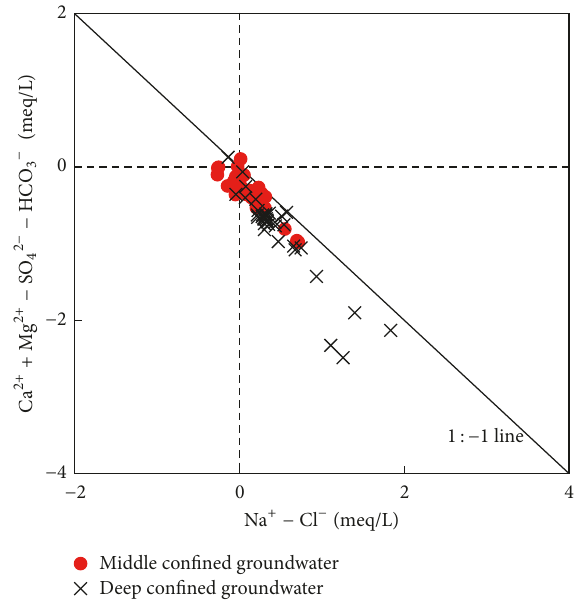
Figure 10: Plot of (Ca 2+ + Mg 2+ − HCO 3− − SO 42− ) versus (Na + − Cl −